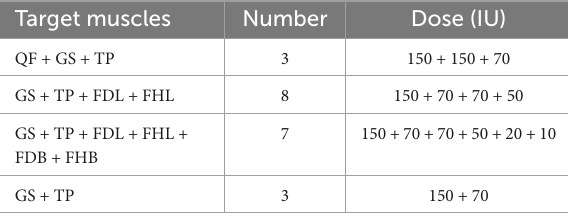
TABLE 1 BoNT-A injection scheme protocol. Target muscles Number